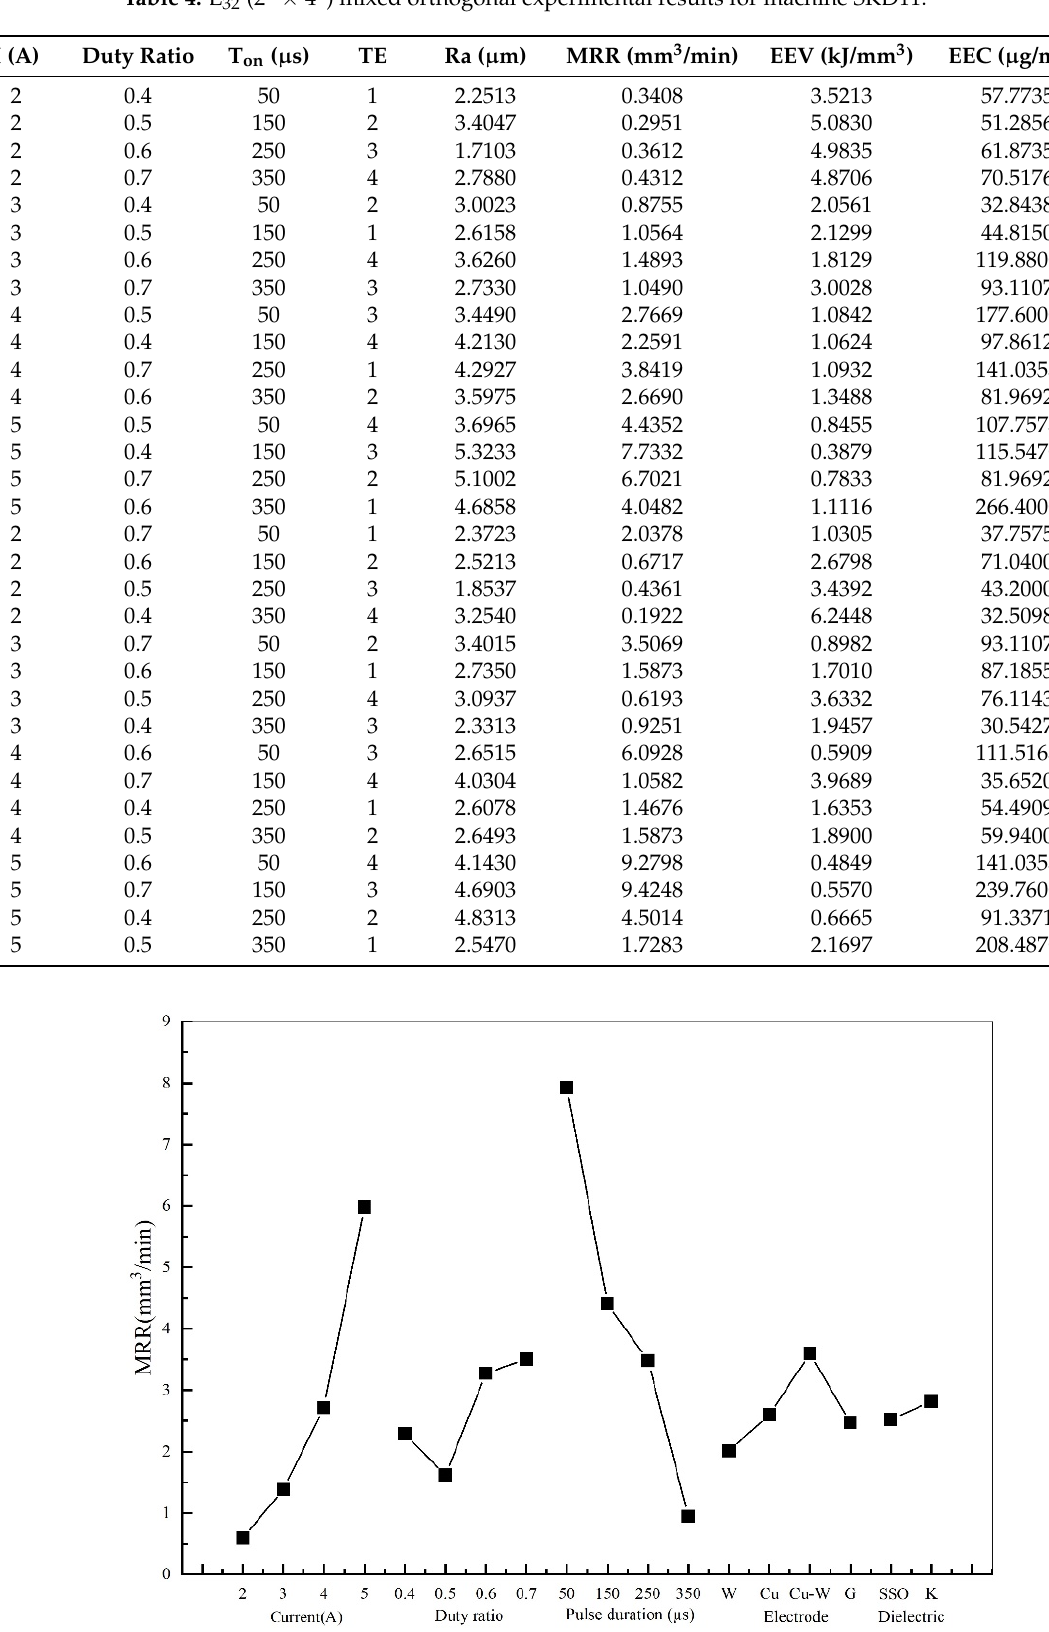
Figure 2. The influence of current, duty ratio, pulse duration, electrode and dielectric on MRR.